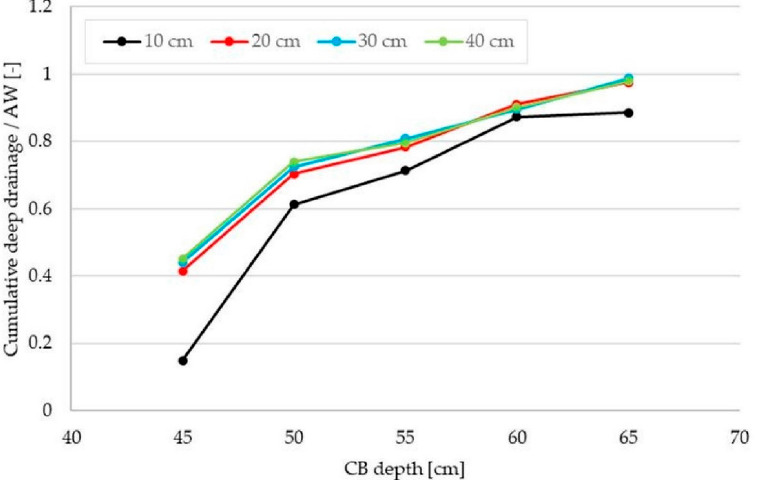
Figure 7. Cumulative deep drainage expressed as a fraction of AW during the 28-day simulations when the ring-Scheme 10. 20, 30, and 40 cm) are shown using lines of different colors.